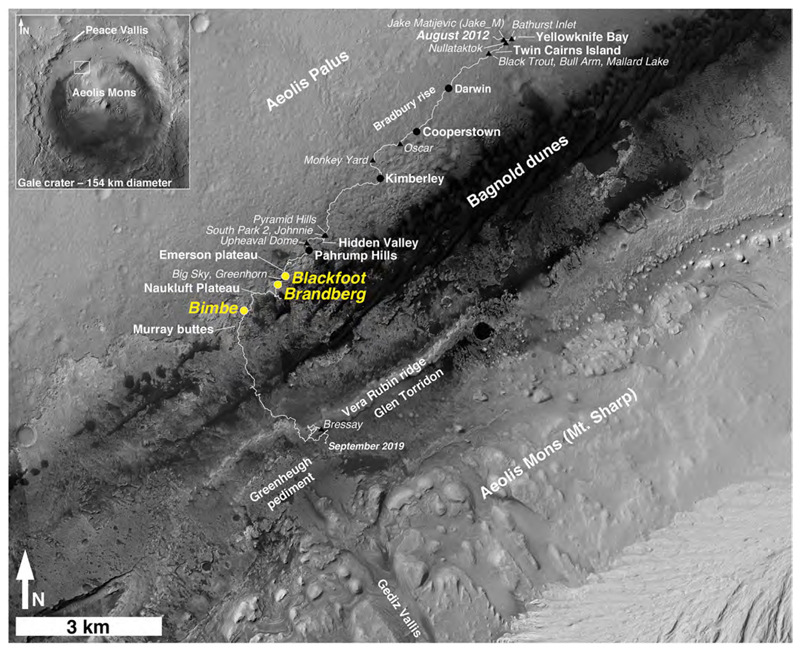
The Curiosity rover field site occurs on the lower northwest slope of the 5-km-high Aeolis Mons (Mt. Sharp), a mountain of predominantly stratified sediments in Gale crater. Gale is a ~154 km diameter impact structure. The white trace indicates the rover traverse from landing until September 2019. The inset shows the location of the field site within Gale crater. The three heterolithic units studied by the rover are indicated by filled circles. Waypoints are indicated by black circles. Targets mentioned in the text that are outside of the heterolithic units are indicated by triangles. Other features mentioned in the text are also indicated.